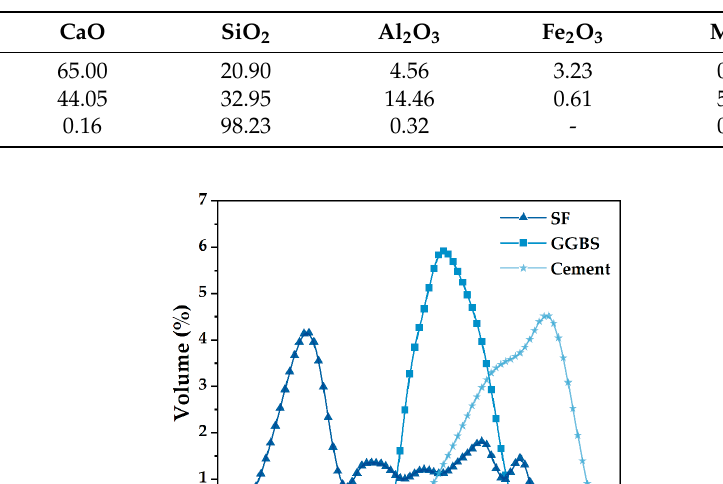
Figure 2. The photographs of ( a ) cement, ( b ) slag, and ( c ) SF. Table 1. Chemical compositions of cement, slag, and silica fume.